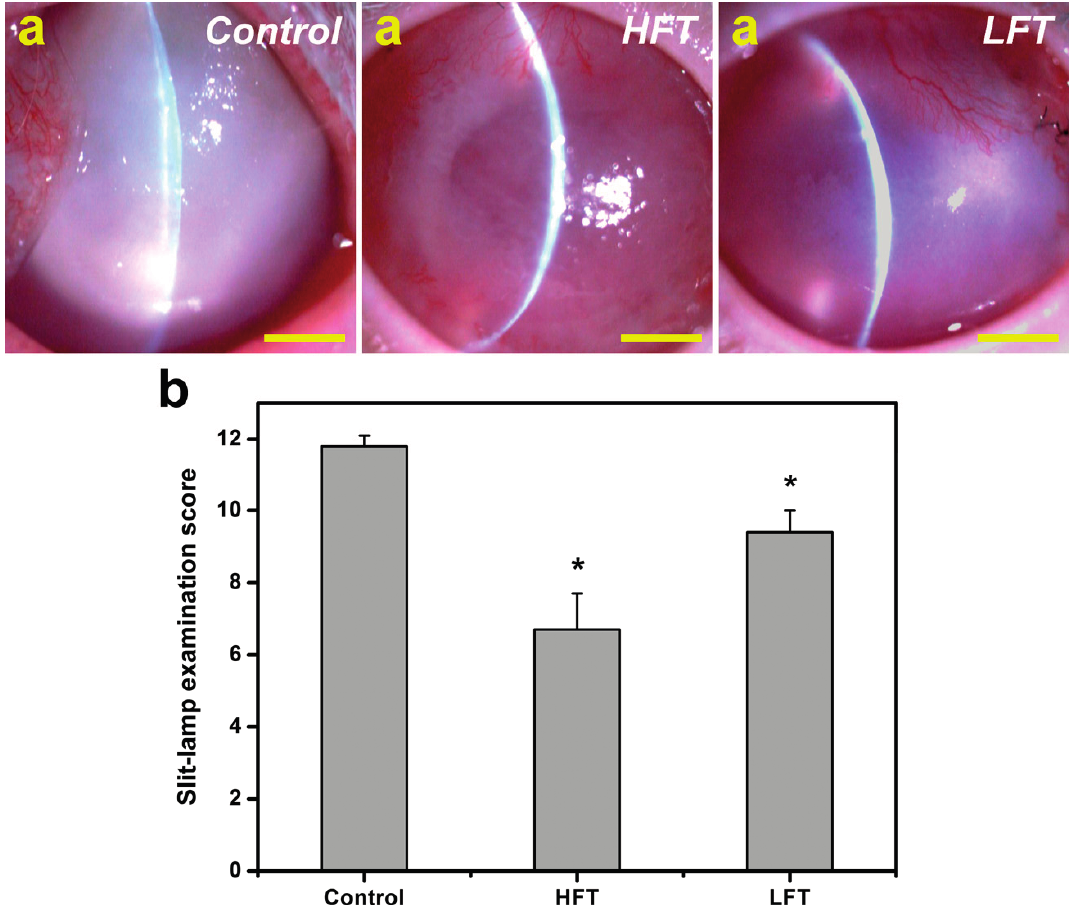
Figure 7. ( a ) Representative slit-lamp biomicroscopic images of rabbit eyes four weeks after surgical treatment of corneal endothelial dysfunction. Control group: cornea denuded of endothelium; HFT group: endothelial scrape-wounded cornea implanted with HFT carriers and bioengineered CEC sheet; LFT group: endothelial scrape-wounded cornea implanted with LFT carriers and bioengineered CEC sheet. Scale bars: 5 mm; ( b ) Slit-lamp examination scores of rabbit eyes four weeks after surgical treatment of corneal endothelial dysfunction. An asterisk indicates statistically-significant differences ( * p < 0.05; n = 6) as compared to the control